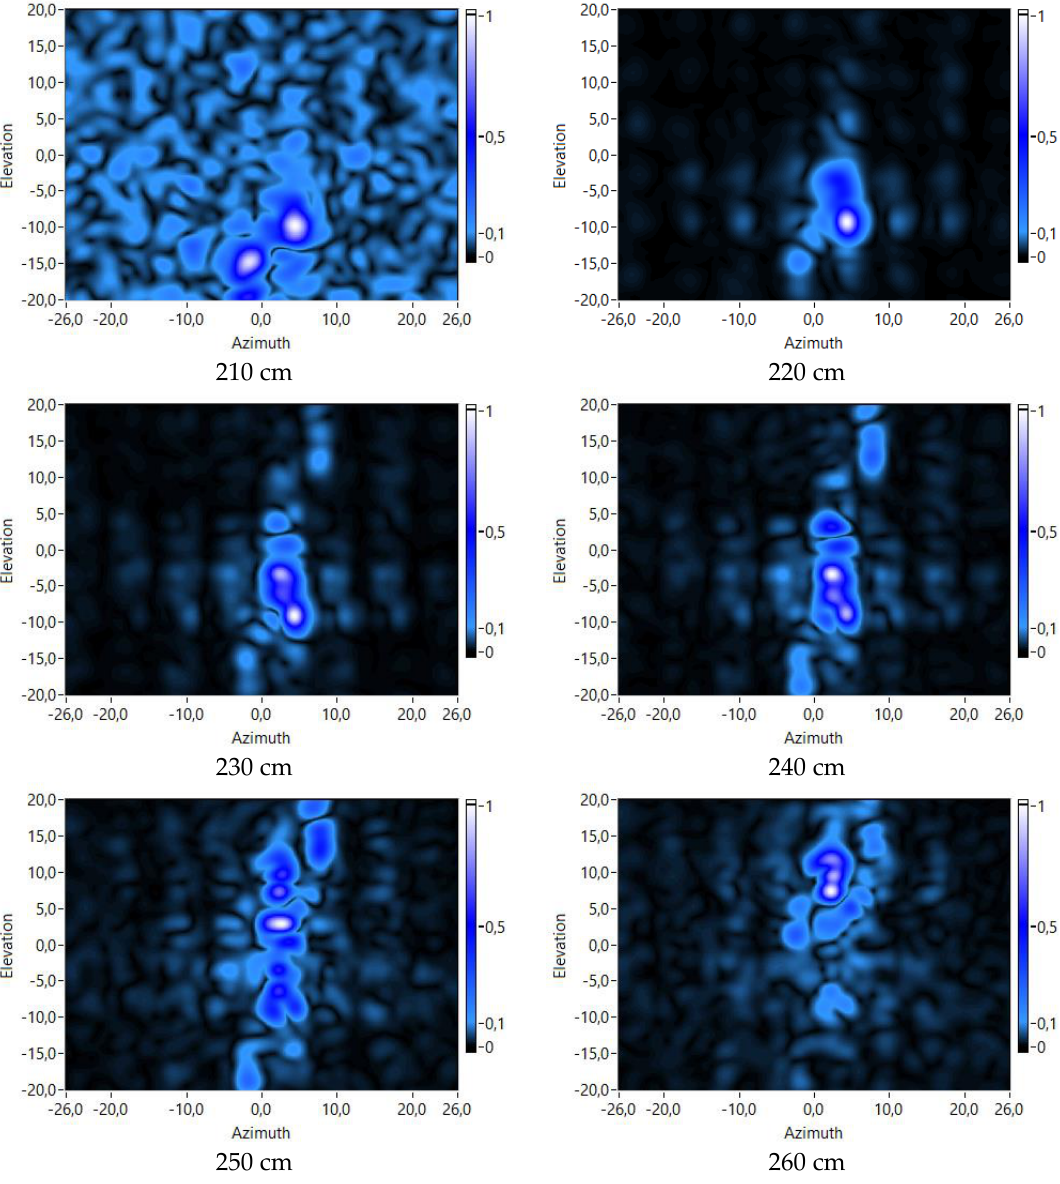
Figure 13. Virtual array responses for several ranges and a frequency of 13 kHz.